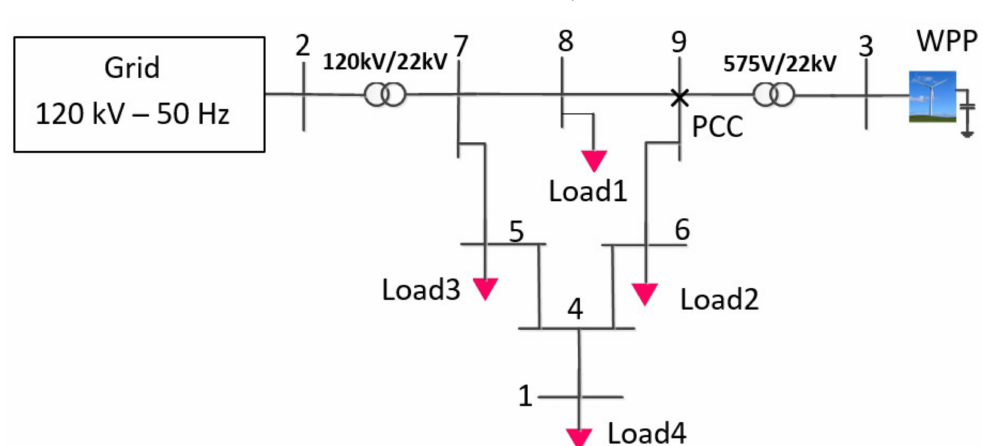
Figure 1. 37-bus test system.